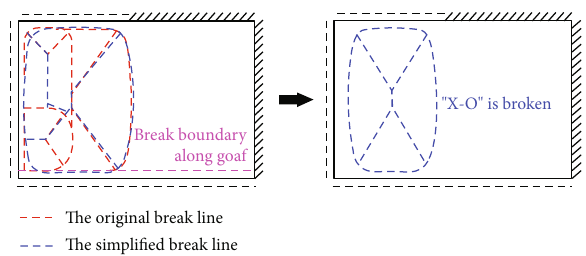
Figure 21: “ X-O-shaped ” fracture law in full-scale mining stope.